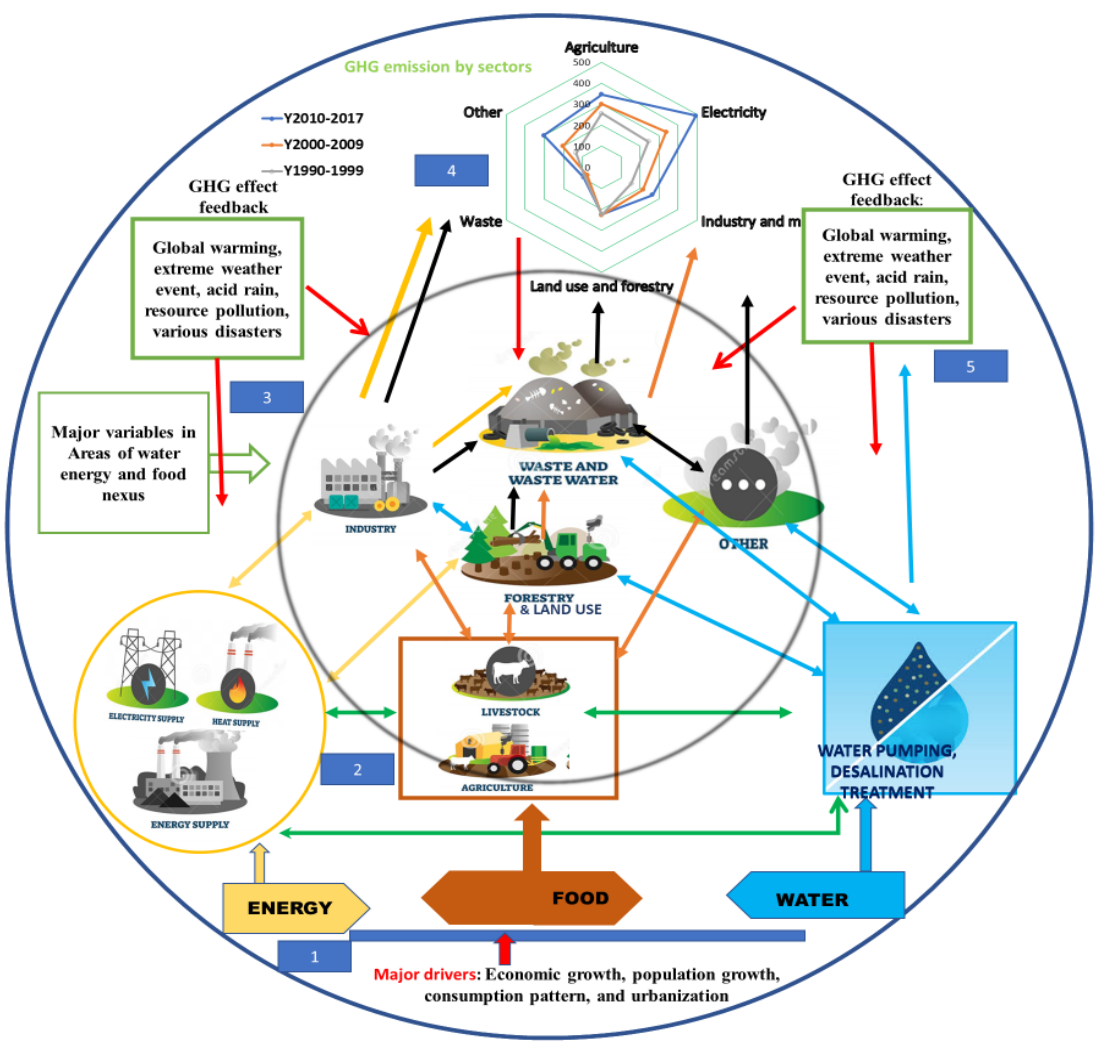
Figure 8. EWF nexus in GHG emissions cycle.